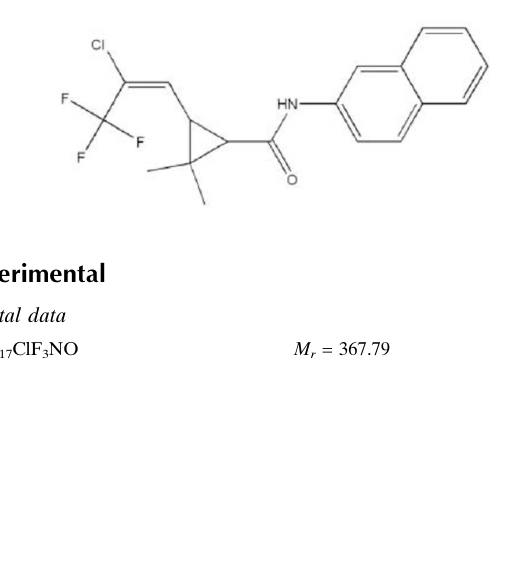
two molecules in the asymmetric unit. The dihedral angle between the naphthalene and cyclopropane units is 111.6 (5). Molecules are connected into chains by intermolecular N— H (cid:1) (cid:1) (cid:1) O hydrogen bonds. One of the Cl atoms is disordered over two positions with occupancies 0.653 (15) and 0.347 (15).